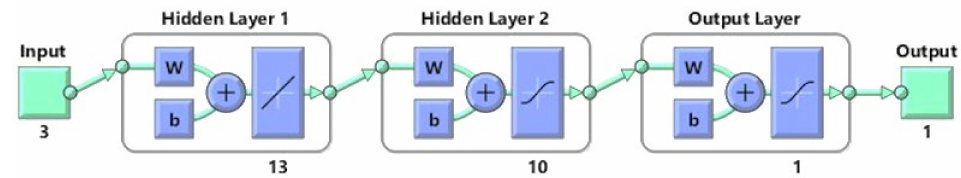
Figure 6. Best network topologies with Levenberg-Marquardt training algorithm for prediction of antioxidant activity